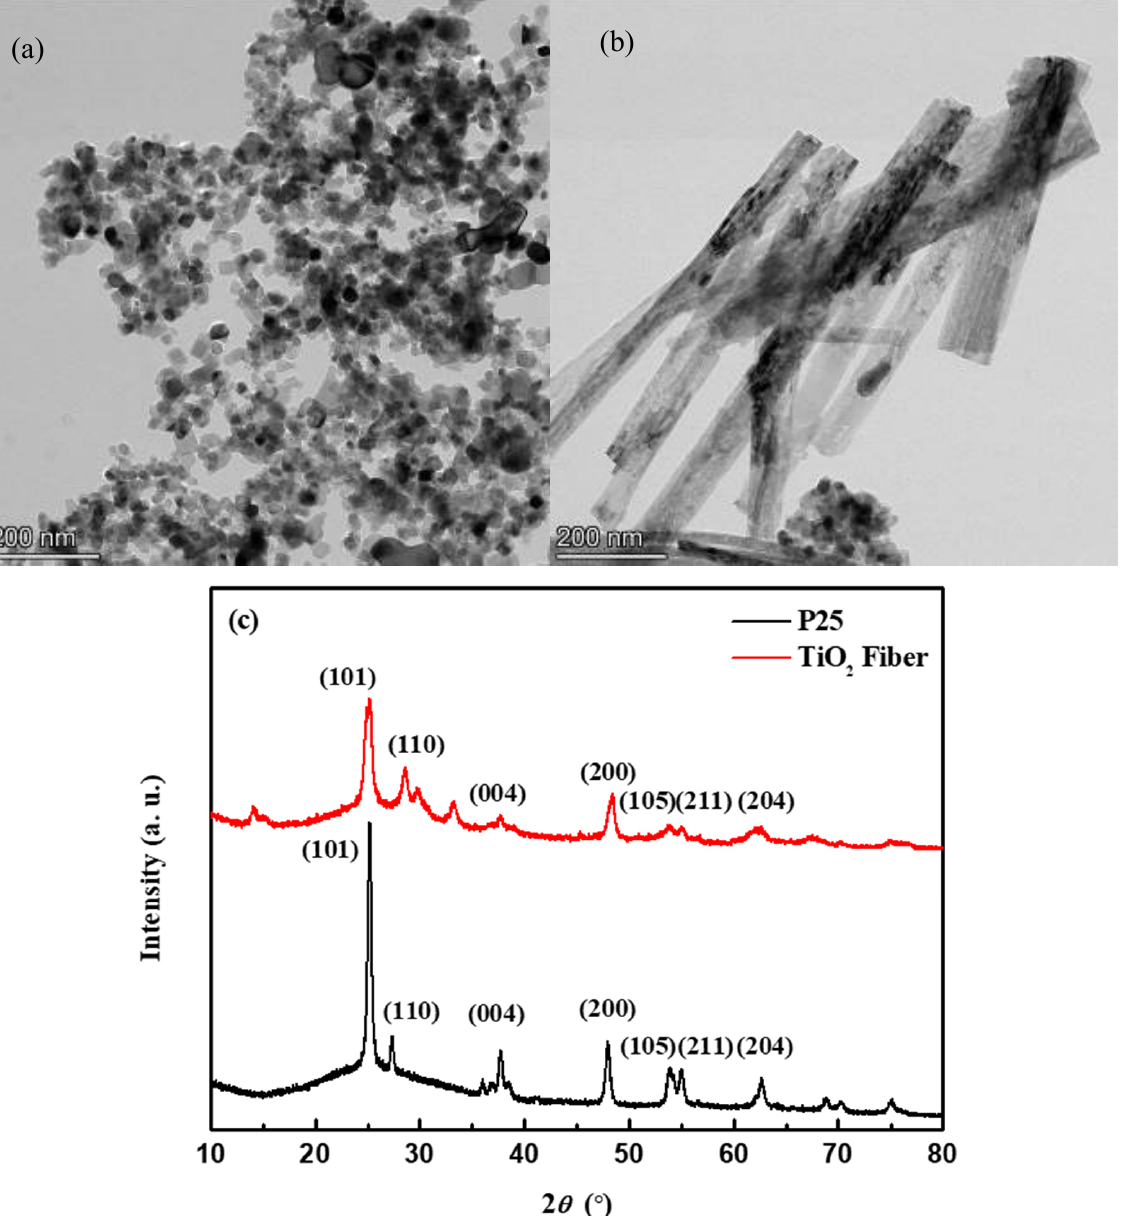
Figure 2. Morphological and compositional analysis of TiO 2 . TEM of P25 ( a ) and TiO 2 fiber ( b ), and XRD of P25 and TiO 2 fiber ( c ).